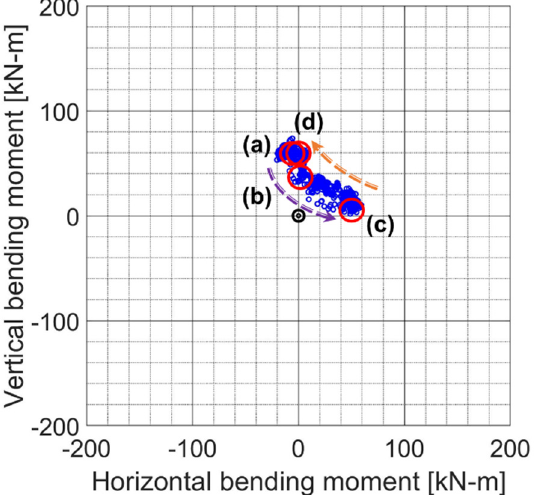
Figure 20. Bending moment during the starboard turn under the normal ballast condition. The average values of the trajectories for the going straight ahead, port turn, and starboard turn cases are shown in Figures 21 and 22.